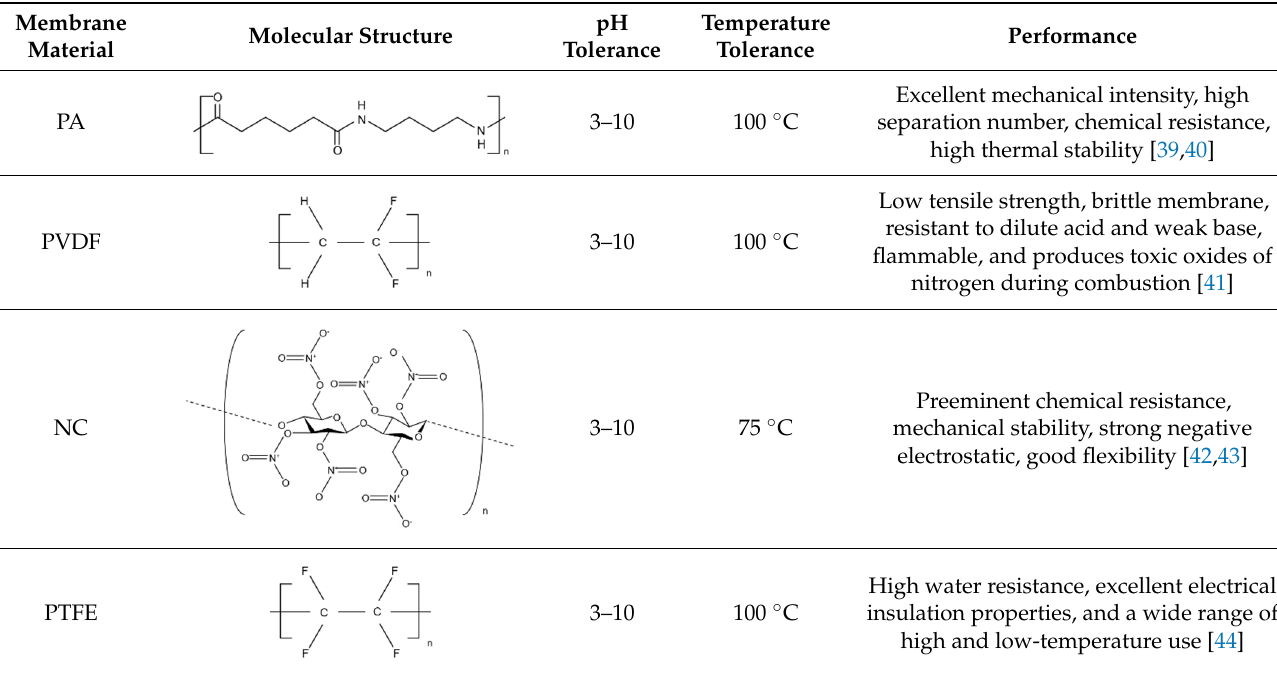
Figure 1. The chemical structure of BPA. Table 1. Properties of four MFMs.